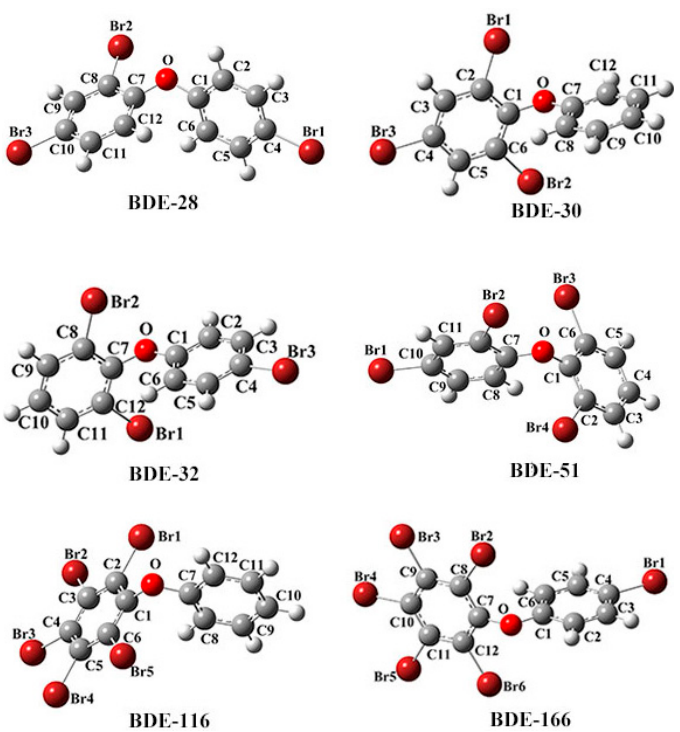
Figure 1. The molecular structures for BDE-28, BDE-30, BDE-32, BDE-51, BDE-116 and BDE-166, with the atom-numbering scheme. Table 2. Comparison of structural parameters for the selected PBDEs calculated at the